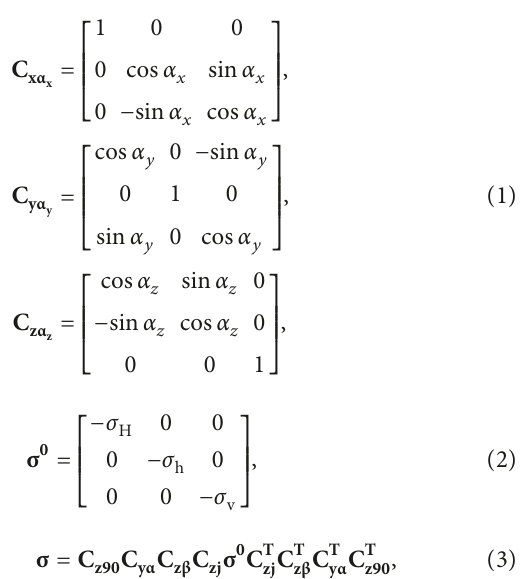
Figure 2: Loading process of the new method. Outer boundary temperature, T shear stress, τ xy ; drilling mud pressure, P m ; cement slurry pressure, P c ; fracturing pressure, P f .